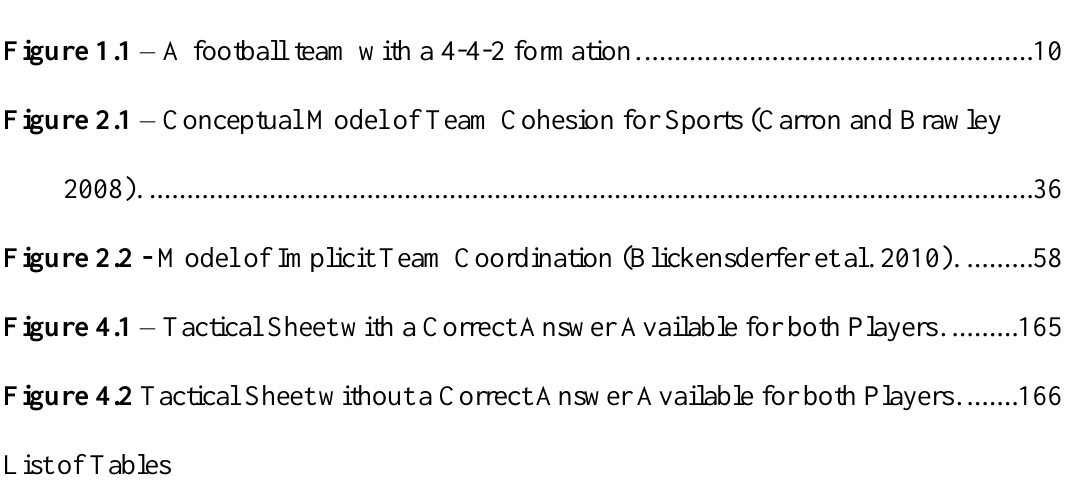
Table 3.1 – Mean and standard deviation values for Actual and Random Dyads. ...... 123 Table 3.2 – Mean and standard deviation values for Typical and Atypical Dyads...... 124 Table 3.3 – Comparisons of Actual to Random Dyads ................................................ 125